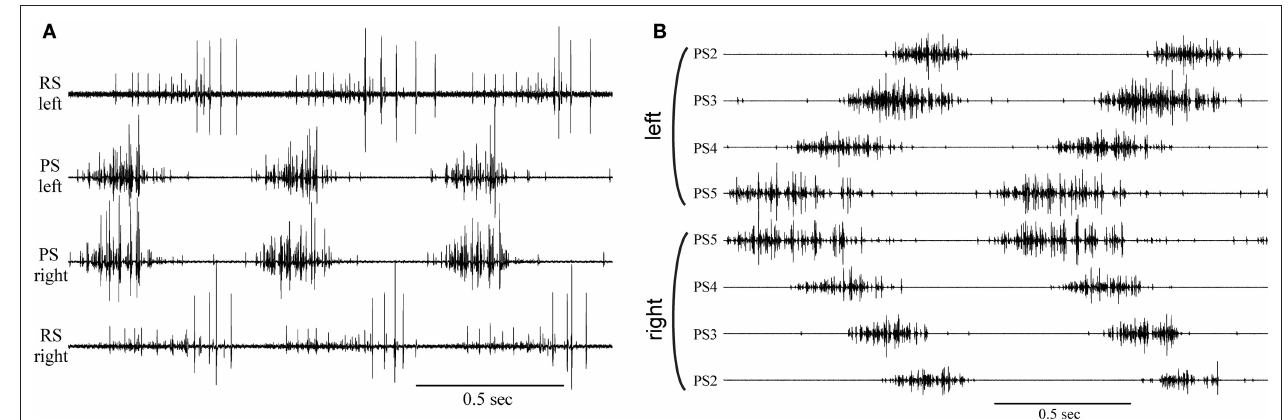
innervating four pairs of swimmerets of four segments of the abdomen. Each cycle begins with a burst of spikes in PS axons in the most posterior swimmeret ganglion (PS5). PS motor neurons in more anterior ganglia, PS4, PS3, PS2, follow in order with increasing lags. In each segment, left and right PS bursts occur simultaneously. Note: These recordings are our own work. The original figures in Hughes and Wiersma (1960) show only two traces, photographed with a 16-mm camera from the screen of a Dumont 322 oscilloscope. The totality of their observations can be grasped only by comparing multiple